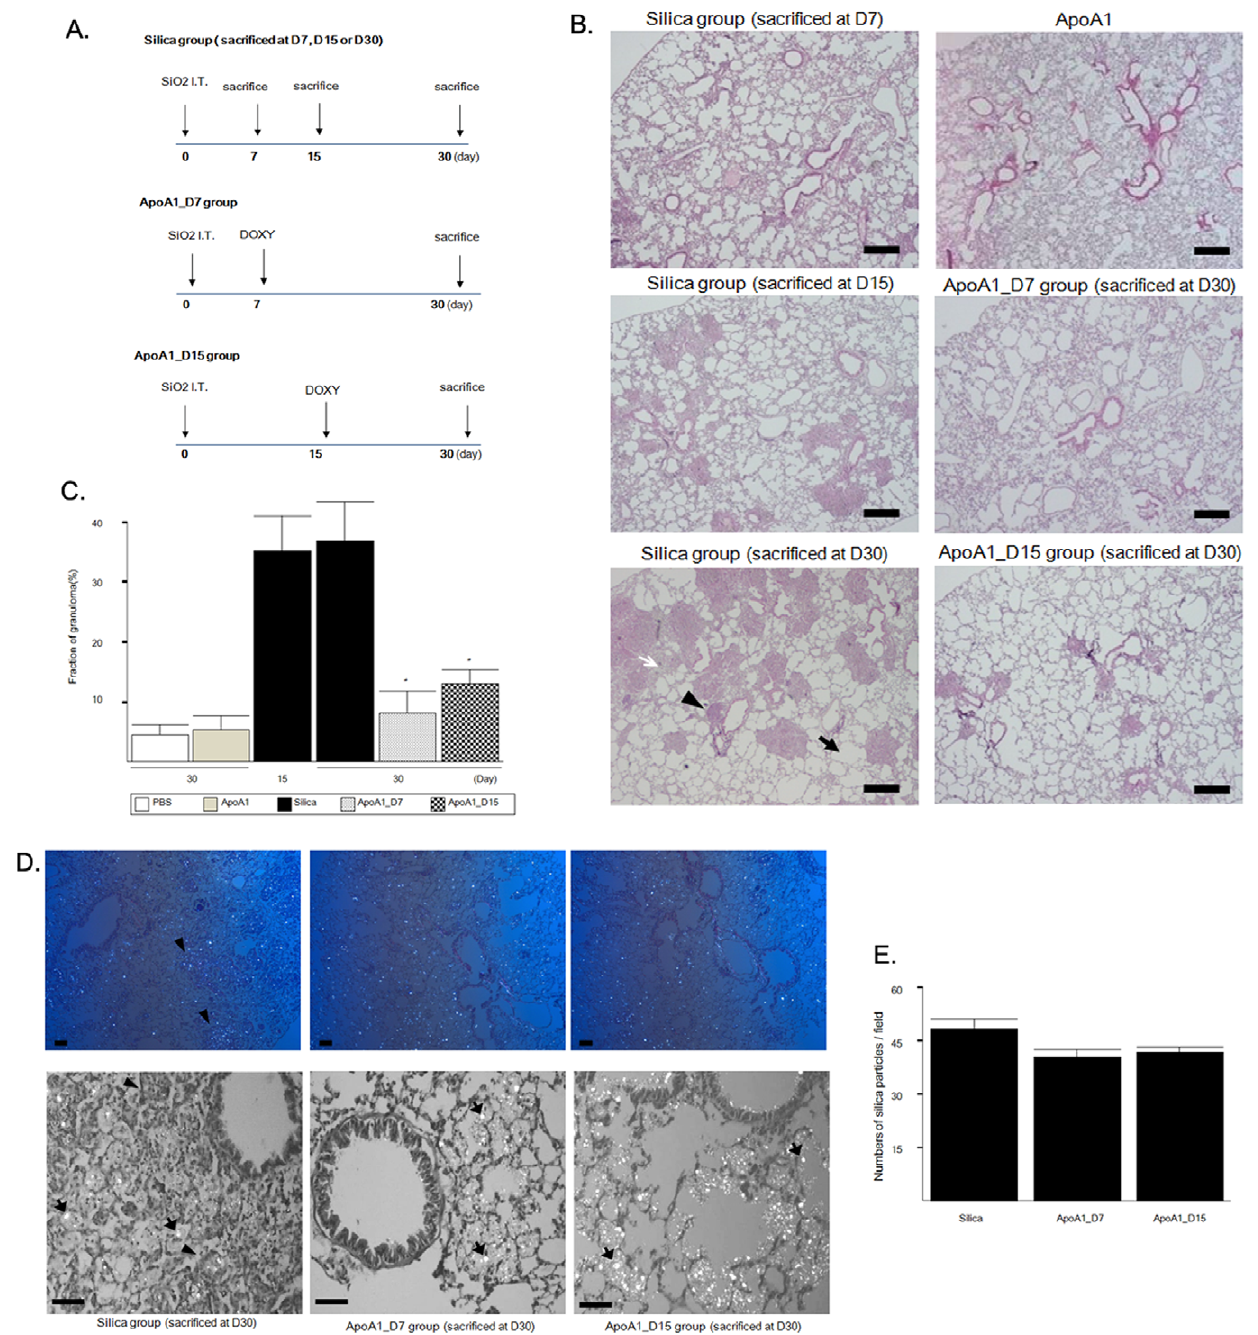
Figure 2. Experimental protocol and histological analysis of lung tissues from ApoA1 transgenic mice. ( A) Silica was administered via the trachea to ApoA1 transgenic mice (6 to 8 weeks old) on day 0. The mice were given drinking water containing doxycycline to induce hApoA1 overexpression beginning on day 7 (ApoA1_D7 group) or 15 (ApoA1_D15 group) and continuing throughout the experiment. A third group of silica- treated transgenic mice, which received drinking water with no doxycycline during the experiment (Silica group), were sacrificed 7, 15, or 30 days after silica administration. The ApoA1_D7 and D15 mice were sacrificed 30 days after silica administration. ( B) Hematoxylin and eosin staining of lung sections from the transgenic mice following silica administration and doxycycline treatment on day 7 (ApoA1_D7) or 15 (ApoA1_D15), and in those that received no doxycycline treatment (Silica group). Silica group D7, D15, and D30 correspond to mice sacrificed 7 (D7), 15 (D15), or 30 days (D30) after silica administration, respectively. Scale bar=100 m m. ( C) Quantification of the area occupied by silicotic nodules in the lung ( n =8/group). ** p , 0.01 compared with the Silica group (D30). ( D) Polarizing light microscopic analysis showed silica particles in the alveolar space in the lungs of the Silica, ApoA1_D7, and ApoA1_D15 group mice. Scale bar=20 m m. ( E) Numbers of silica particles were observed at 6 100 magnification using polarizing microscopy, and the number of silica particles in 20 fields per lung was counted ( n =8 mice/group).